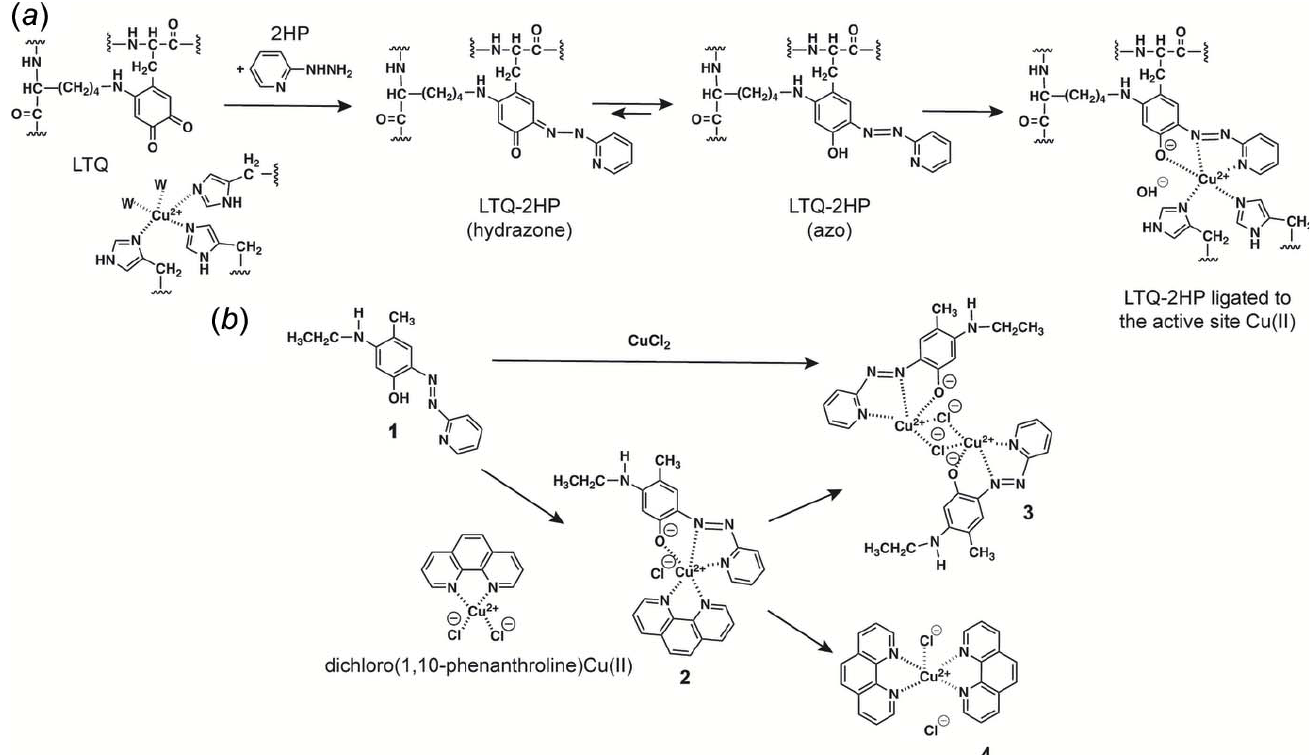
Figure 1 ( a ) The covalent modification of the LTQ cofactor of LOXL2 by 2HP. After the tautomerization of the hydrazone to the azo form, LTQ-2HP ligates to the active site Cu 2+ . The 2HP-modified LTQ (LTQ-2HP) containing the peptide was detected by mass spectrometry (Meier, Go, et al. , 2022). Based on the close resemblances of UV–vis and resonance Raman spectra of 2HP-inhibited LOXL2 and the model compound 2 , we hypothesize that LTQ-2HP serves as a tridentate ligand to the active site Cu II in LOXL2 (Meier, Moon et al. , 2022). The +2 charge of Cu II is expected to be canceled out by the 4-oxoanion of LTQ-2HP and a nearby acidic residue or a water molecule (Meier, Kuczera et al. , 2022). ( b ) During the recrystallization of the dark red solids ( 2 ) isolated from an equimolar mixture of the LTQ-2HP model compound ( 1 ) and CuCl 2 (phen) in anhydrous methanol, we first isolated dark-red crystals ( 3 ), then also isolated ( 4 ) from the mother liquor that was left for a week at room